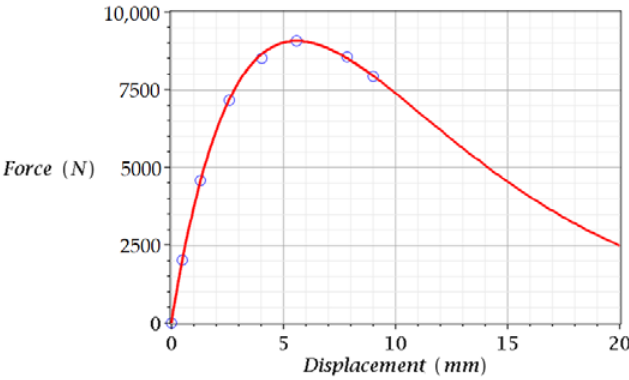
Figure 7. The full load–displacement curve (14) for frozen sandy soil. Experimental data are shown by markers (circles).